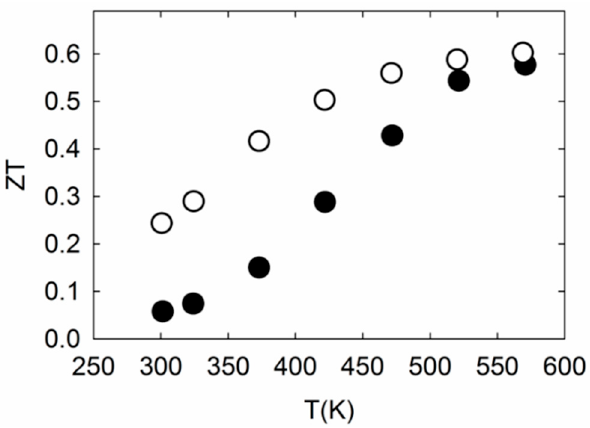
Figure 5. ZT of K 2.9(4) Ba 13.1(2) Ga 23.2(3) Sn 112.7(5) (empty circles) and K 7.1(2) Ba 8.8(3) Ga 25.1(4) Sn 110.8(3) (filled circles).